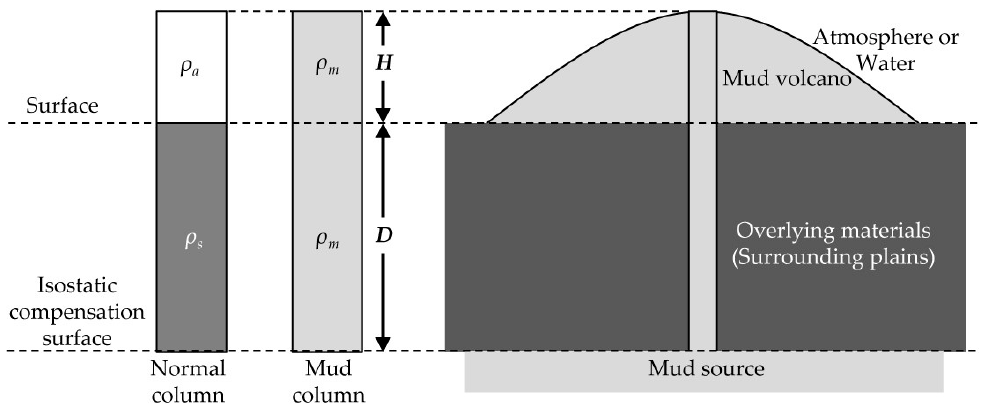
Figure 5. Schematic diagram of a simple buoyancy model of mud volcano formation [83]. D : isostatic compensation depth to the top of the mud source (i.e., thickness of overburden above mud source), ρ m : bulk density of erupted mud through conduit, ρ s : bulk density of overlying materials, ρ a : bulk density of ambient materials.